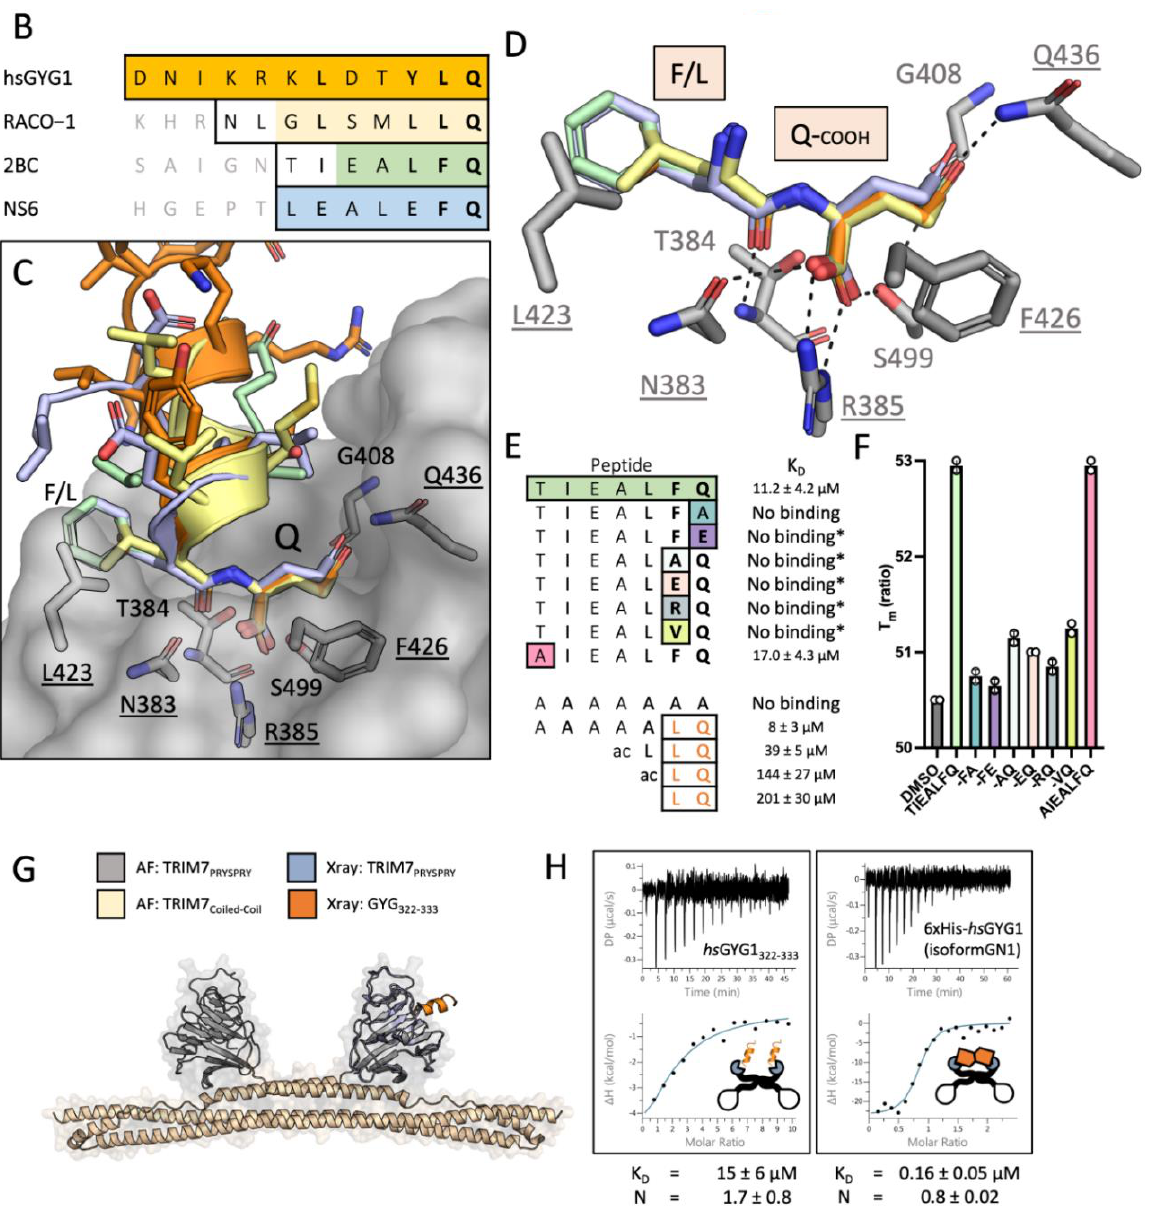
Figure 2. TRIM7 binds diverse substrates using a C-terminal helix- Φ Q motif. ( A ) MNV1 polyprotein (pale blue) and the relevant proteins in a darker shade (NS3 and NS6), CVB3 polyprotein in pale green and the relevant 2C protein in a darker shade. ( B ) Main peptide sequences used in the binding and structural experiments. Outlined are the sequences synthesized, whilst the shaded residues are those resolved in the crystal structures. Color coding is maintained throughout the figure. ( C ) hisTRIM7-PRYSPRY:Peptide complex structures superposed. Shows PRYSPRY as a transparent surface representation with a few key residues in stick. Peptides are color coded as described.